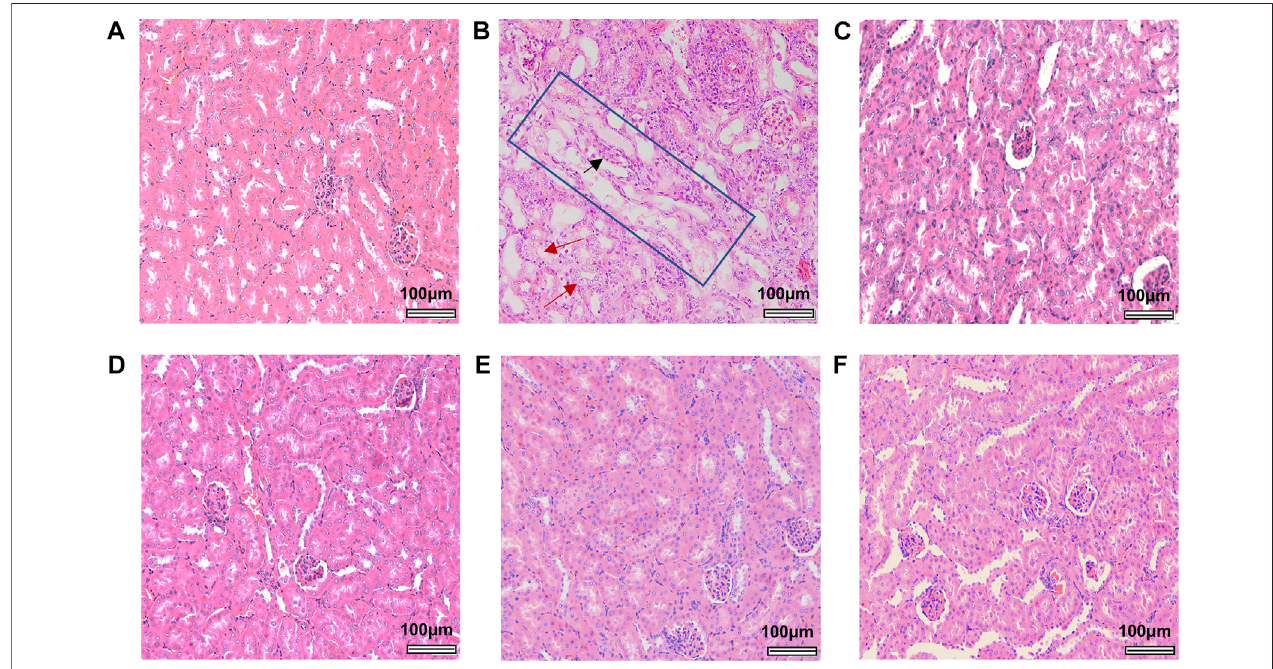
FIGURE4| Histologicalimagesofrenaltissuesfromcontrolandaristolochicacidanaloguestreatedmalemiceataconcentrationof40 mg/kg.Control (A) ,AAI (B) , AAII (C) ,AAIIIa (D) ,AAIVa (E) ,and ALI (F) .Large areasofrenaltubule necrosiswereoutlined inthebluerectangle. Redarrows indicateareas ofepithelialdegeneration of renal tubules. Black arrow indicates the granular casts in renal tubule lumen. All the images were obtained at the same magni fi cation: × 200, scale bar (cid:2) 100 μ m.